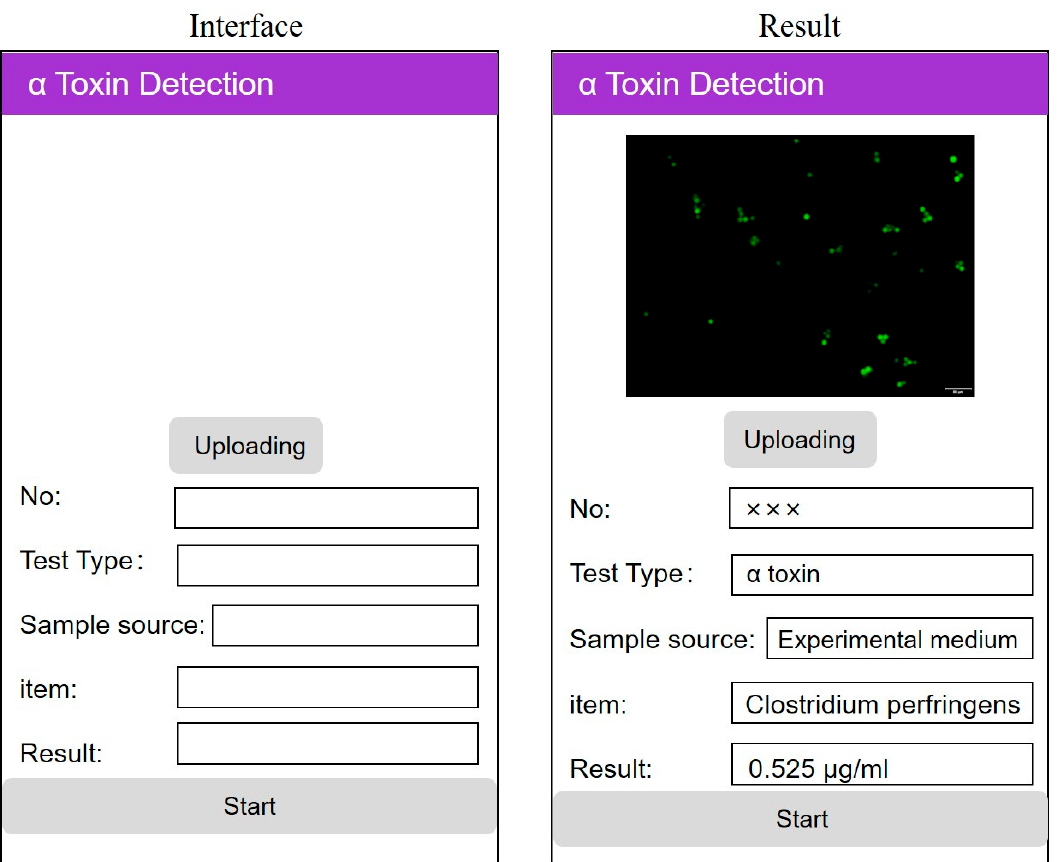
Figure 7. Smartphone APP detection interface. Scale bar = 50 µ